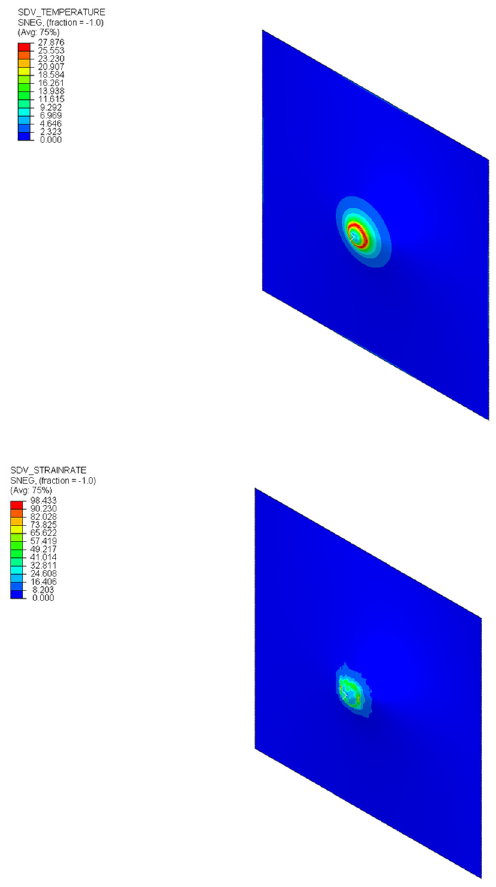
Figure 3. Temperature increase and strain rate plots before fracture initiation.